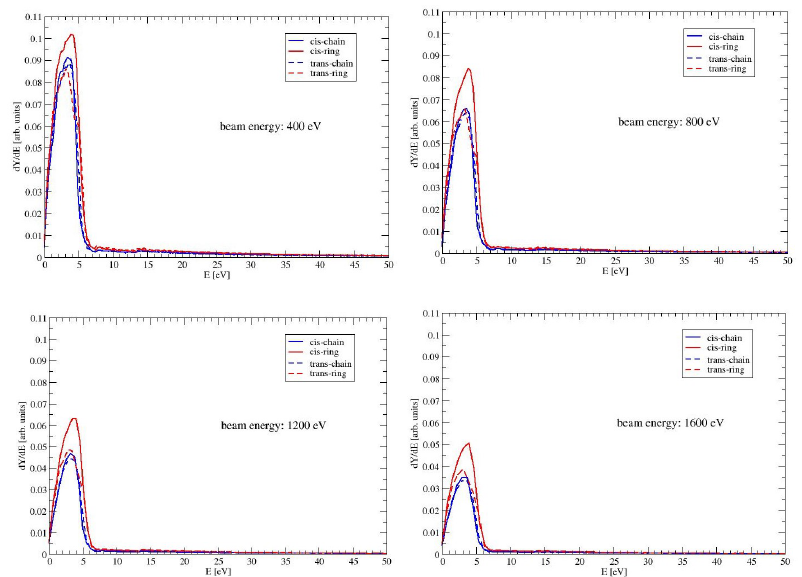
Figure 5. The spectrum of the ejected electrons of the four conformers of MAA. Shown is the low energy part up to 50 eV for beam energies of 400, 800, 1200 and 1600